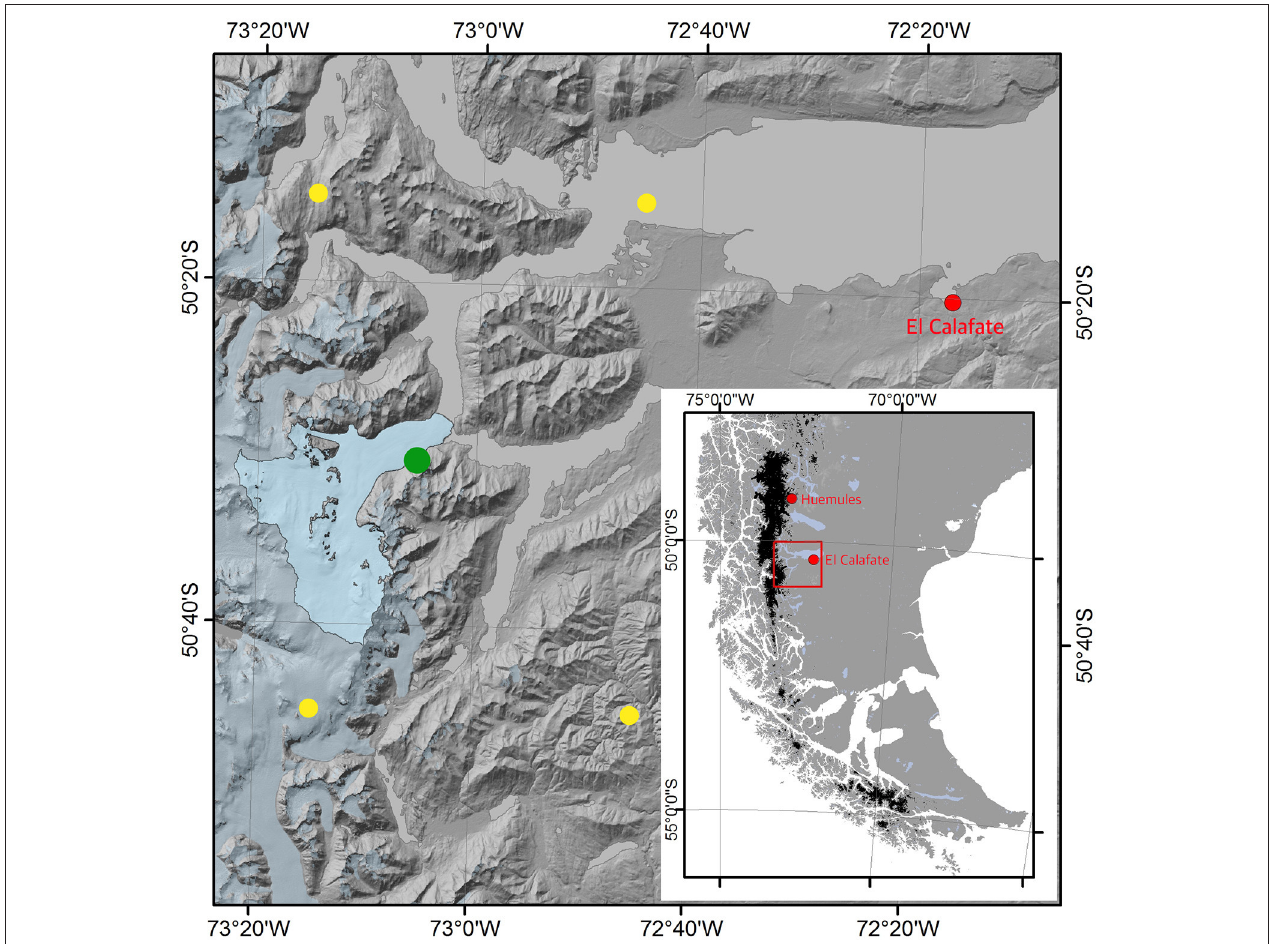
FIGURE 1 | Digital Elevation Model (SRTM) of Southern Patagonia overviewing the investigation area of this study. Bright blue area: Extent and catchment of the Perito Moreno Glacier. Green Circle: location of tree-ring sampling site. The yellow circles represent the four nearest 0.5 ◦ grid points of the CRU TS v. 4.01 dataset. Inlay: Blackened areas in the Inlay mark locations of glaciated areas in South America. Dark blue area: Actual extent of glaciated areas of the Southern Patagonia Ice Field (SPI). Red dots: location of the nearest meteorological stations in El Calafate and Los Huemules